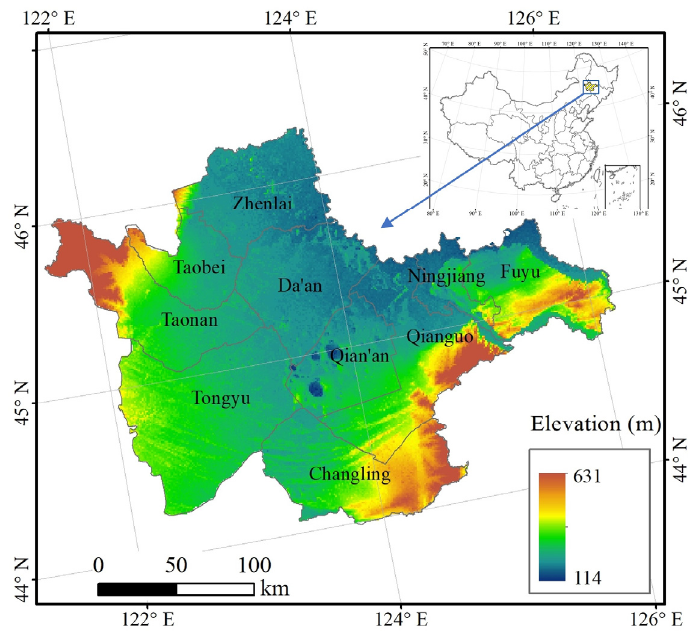
Figure 1. Geographic location of west Jilin.